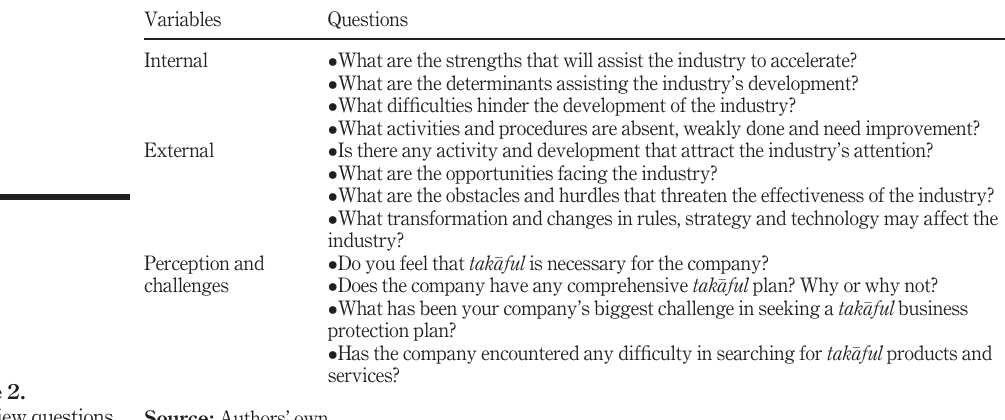
Table 2. Interview questions